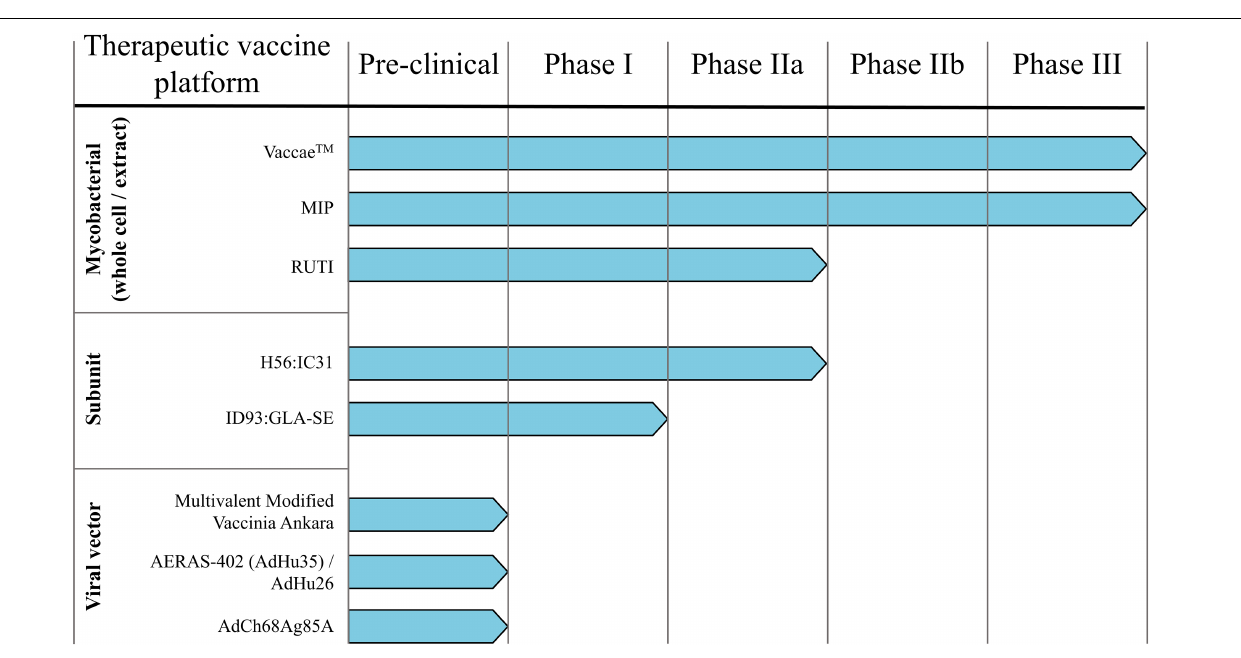
FIGURE 2 | Therapeutic TB vaccine pipeline. Numerous TB vaccine candidates under pre-clinical and/or clinical testing for their prophylactic efficacy are also evaluated as immunotherapies.